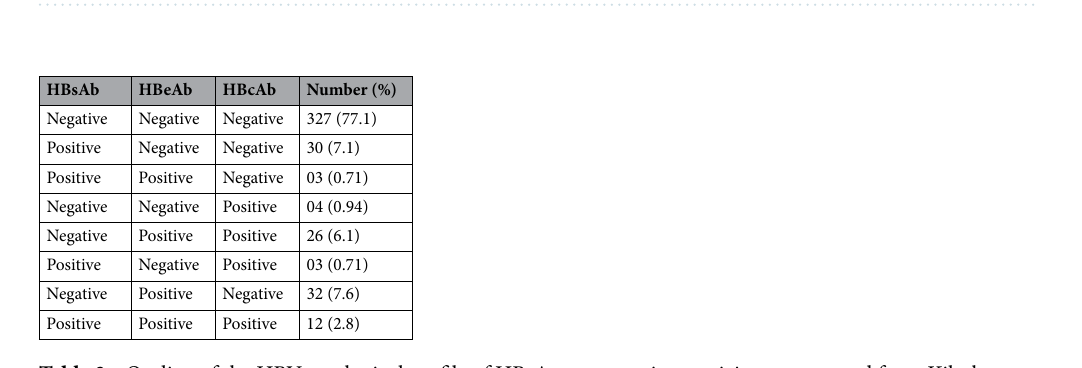
Table 2. Outline of the HBV serological profile of HBsAg seronegative participants screened from Kibuku Health center